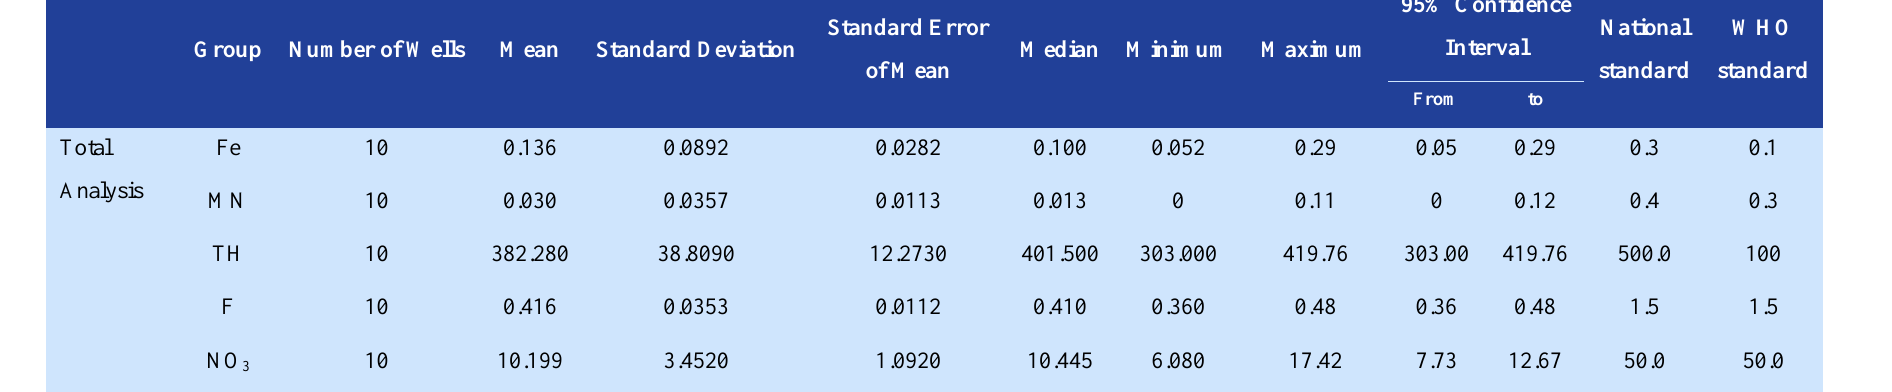
Standard Error Median Minimum Maximum of Mean